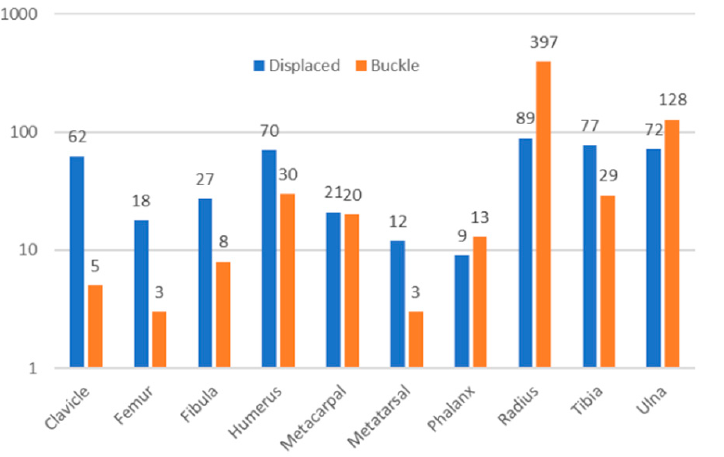
Figure 1. Number of fracture incidents by location (log scale) in displaced (blue) and buckle (orange) fractures.